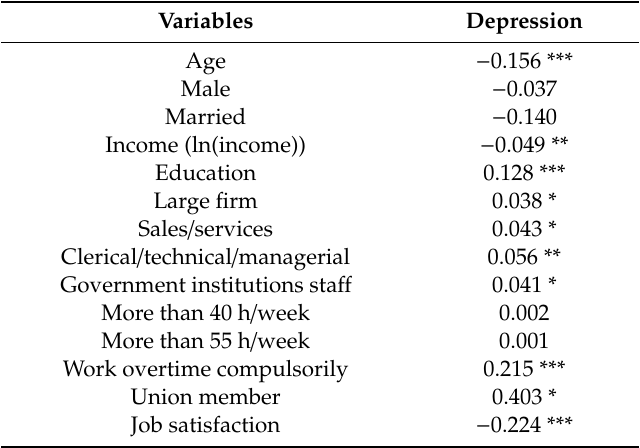
Table 2. Spearman correlation of independent and confounding variables with